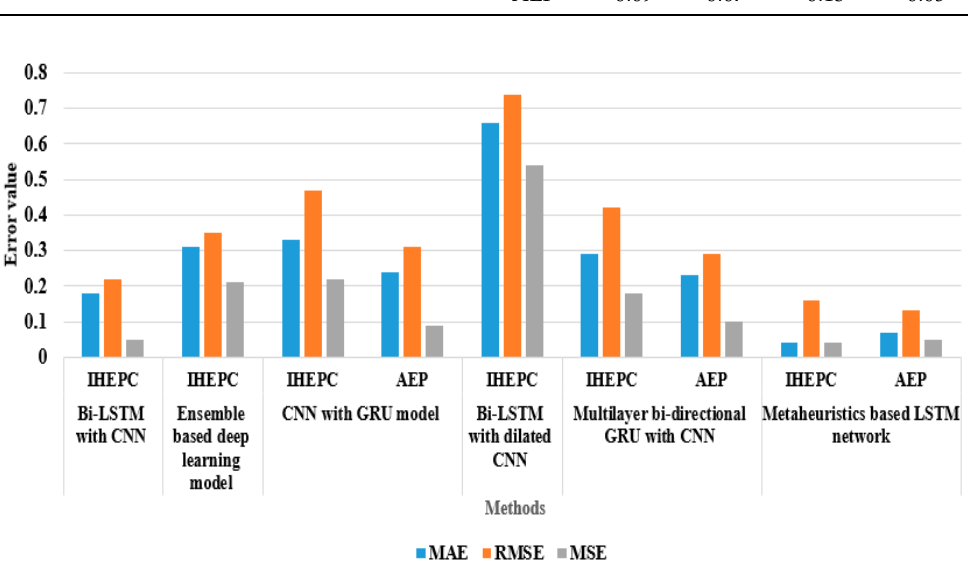
Figure 14. Comparison of the proposed model with the existing